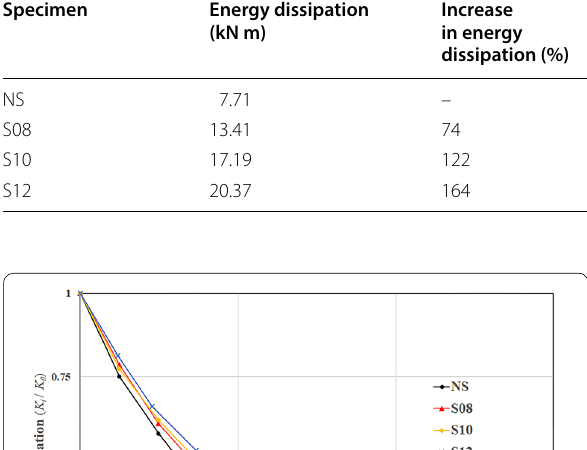
Table 4 Energy dissipation results Specimen